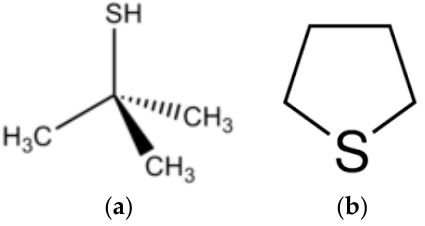
Figure 1. Molecular structure of ( a ) tert-Butylthiol (TBT) and ( b ) tetrahydrothiophene (THT).